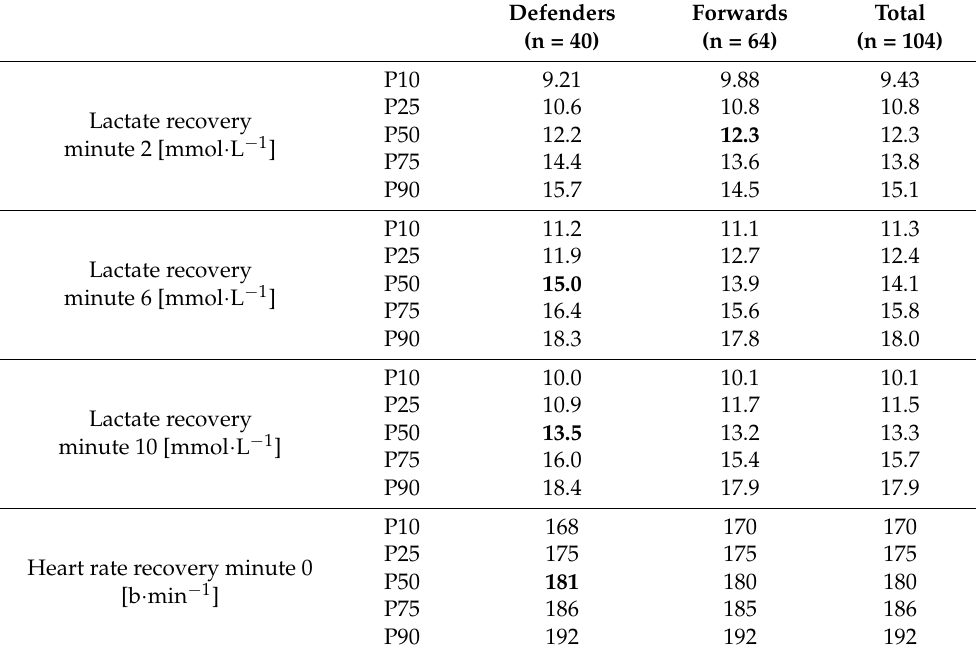
Table 6. Percentile data of stress parameters (lactate, heart rate) by playing position. Based on the 50th percentile, maxima marked in